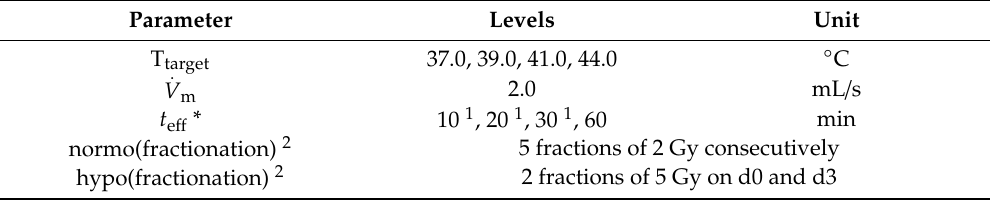
Table 4. Parameter levels for heat treatment (HT&RHT) of breast cancer